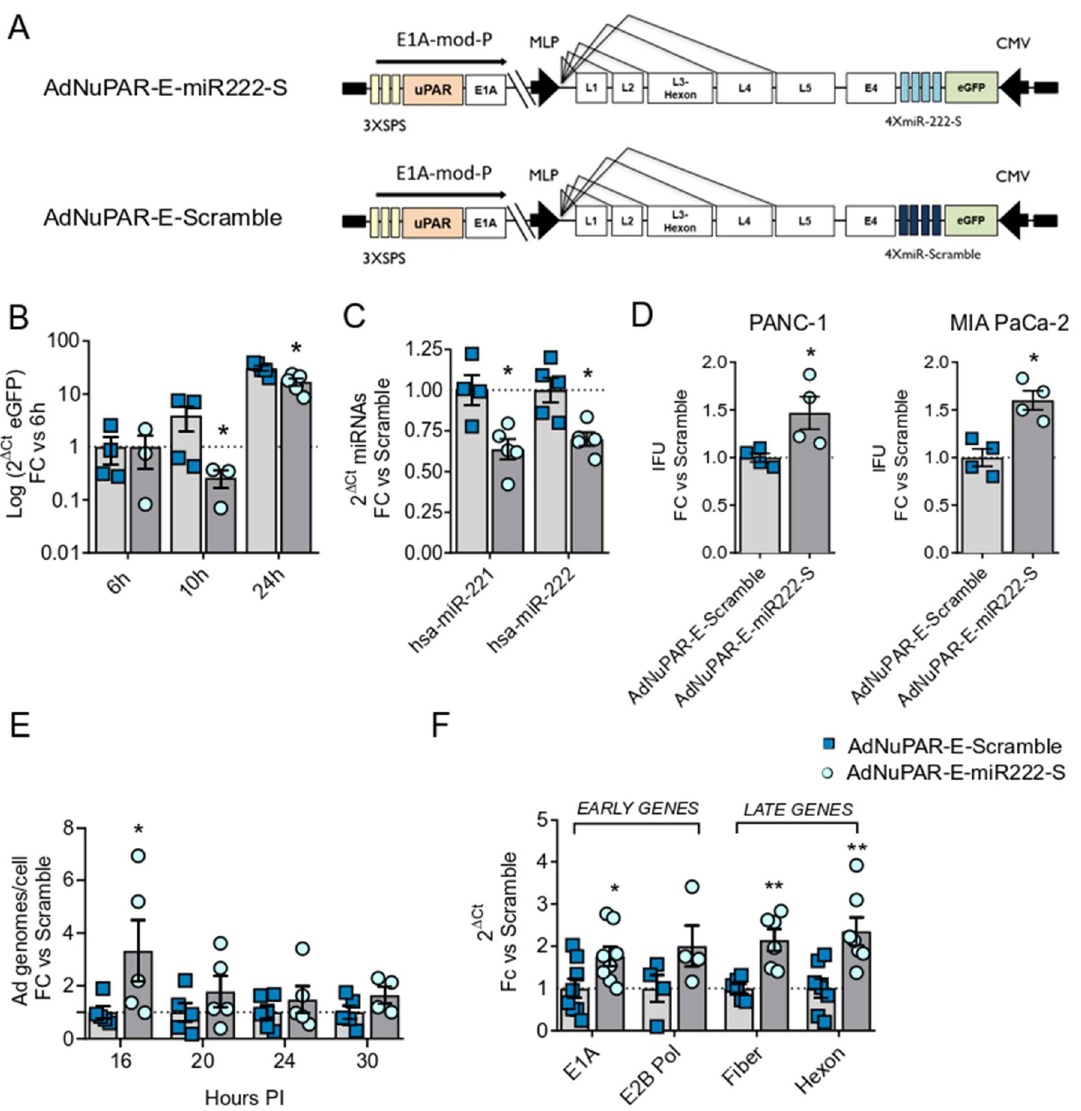
Figure 4. AdNuPAR-E-miR222-S exerts sponge effects over its target miRNAs and displays improved adenoviral fitness. ( A ) Schematic representation of the adenoviral backbones containing the sponge or scramble sequence. ( B ) qRT-PCR of eGFP at the indicated time-points from PANC-1 cells infected with 10 IFU of AdNuPAR-E-miR-222-S or AdNuPAR-E-Scramble. ( C ) q-RT-PCR of miR-221 and miR-222 content in PANC-1 cells at 24 h after infection PDAC cells. ( D ) PANC-1 or MIA PaCa-2 cells were infected with 1 IFU/cell or 5 IFU/cell of either virus, respectively. Seventy-two hours later supernatants were collected and the number of viral particles detected by qRT-PCR quantification of the adenoviral hexon gene. ( E ) Quantification of the intracellular viral genomes at the indicated times PI of PANC-1 cells infected with 2.5 IFU/cells of AdNuPAR-E-Scramble or AdNuPAR-E-miR222-S. Values are represented as adenoviral genomes/cells, with respect to viral genomes at 4h. ( F ) Quantification of E1A, E2B Pol, Fiber and Hexon mRNA levels at 30 h PI in PANC-1 cells infected with 10 IFU/cell of either virus. Data are shown as mean ± SEM for at least four independent biological replicates. Significance was assessed using a two-tailed Mann–Whitney test. * p < 0.05, ** p < 0.01.